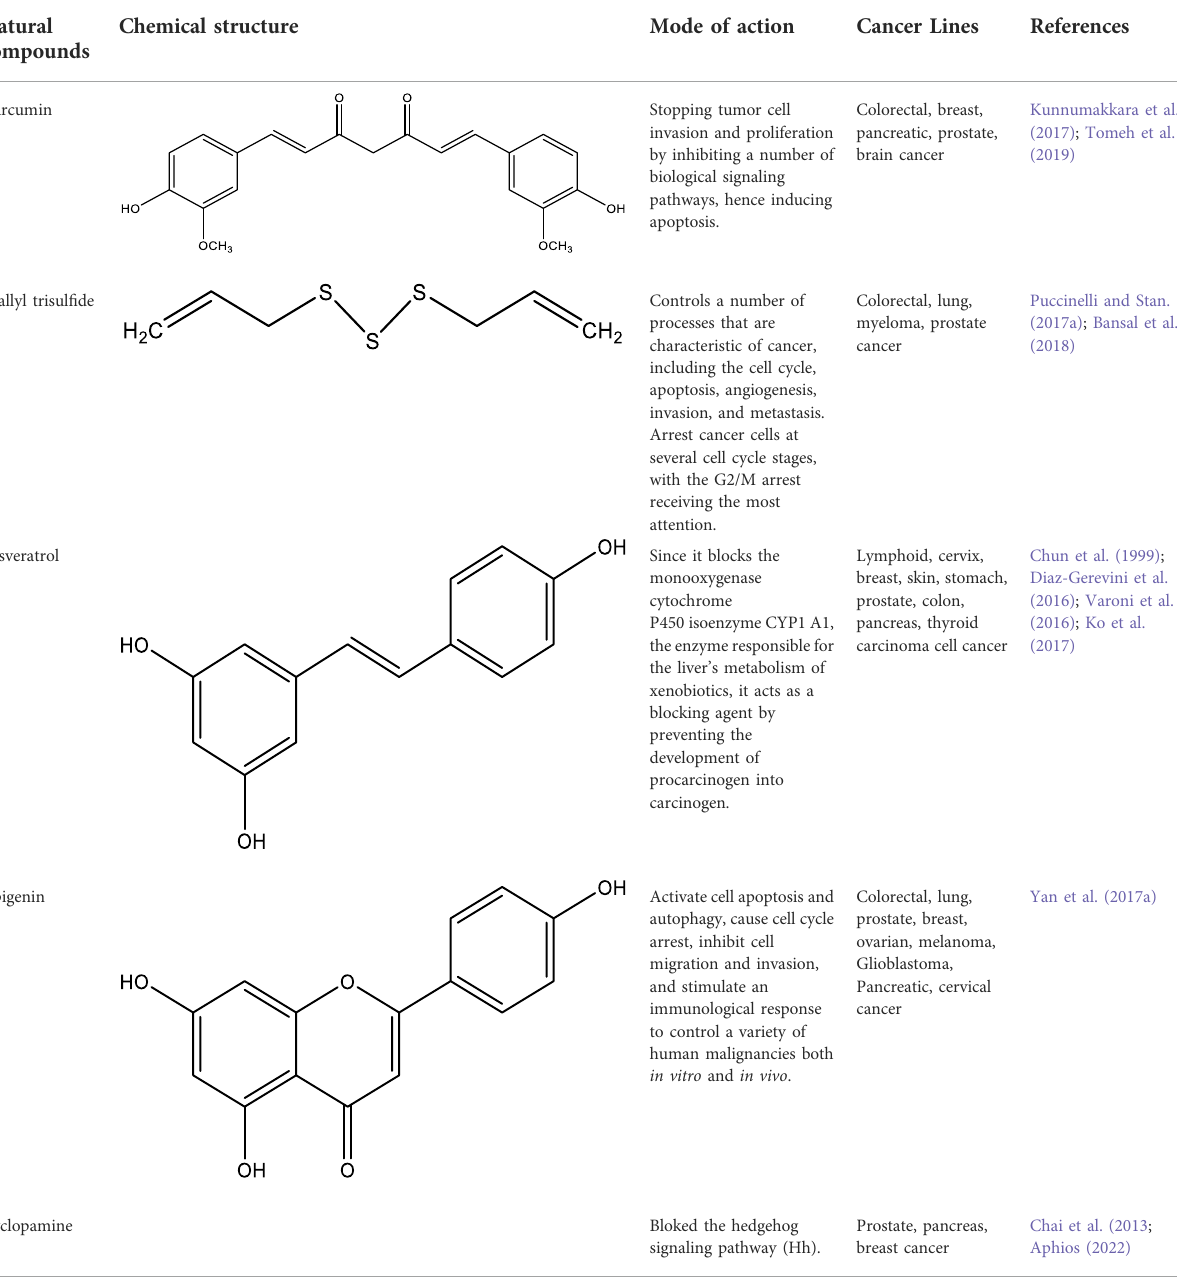
TABLE 3 Mode of action and chemical structure of natural